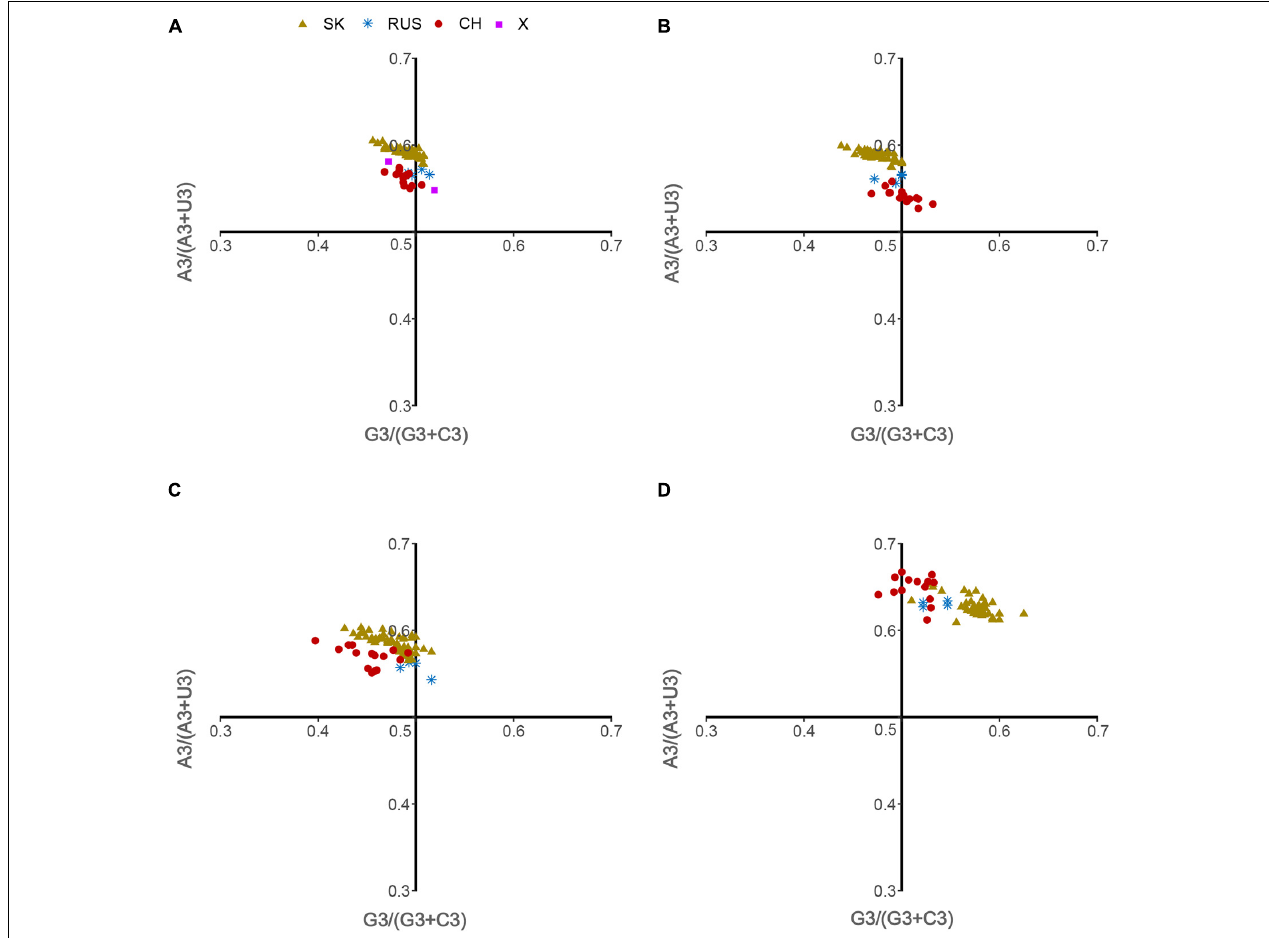
FIGURE 5 | Parity Rule 2 (PR2) analysis. (A) Overall genome, (B) L-segment, (C) M-segment, and (D)